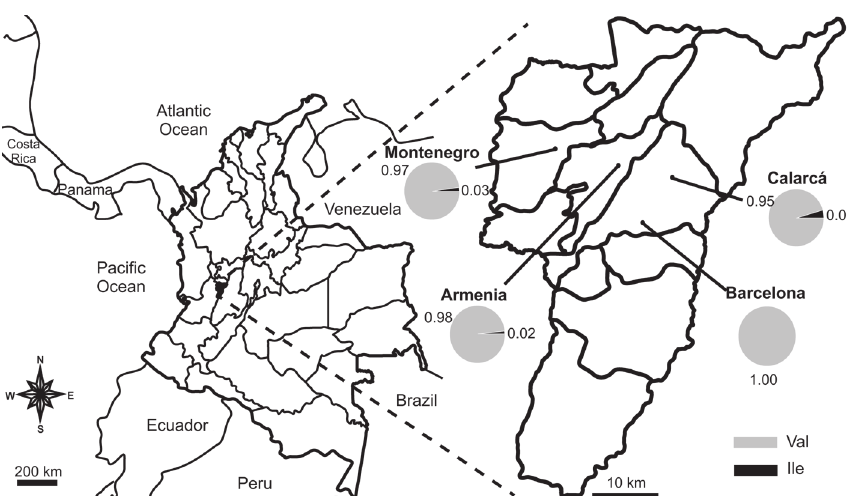
Figure 1. Allelic frequencies of 1016Val and 1016Ile in the Na